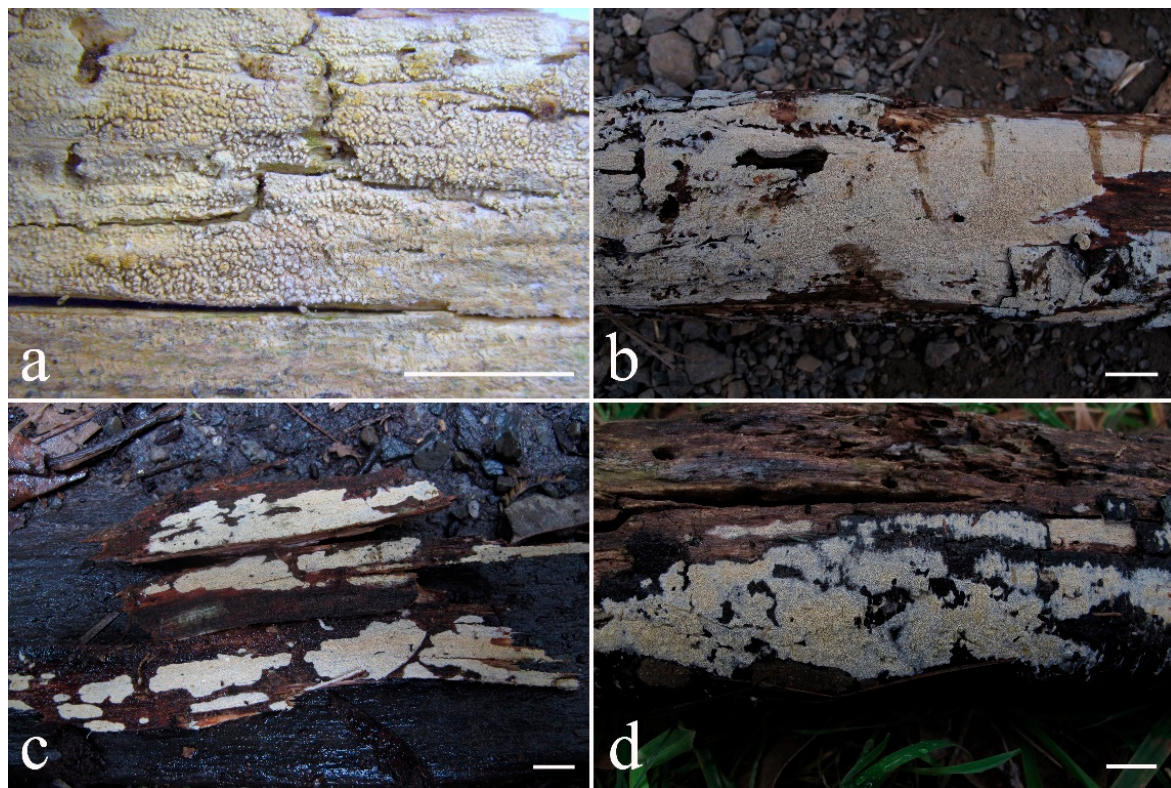
Figure 34. ( a ) Basidiocarps of Xylodon yarraensis ; ( b ) LWZ 20180509-7 (holotype); ( c ) LWZ 20180510-19 (paratype); ( d ) LWZ 20180512-22 (paratype). —Scale bars: a = 5 mm; b = 1 cm; c , d = 2 cm.